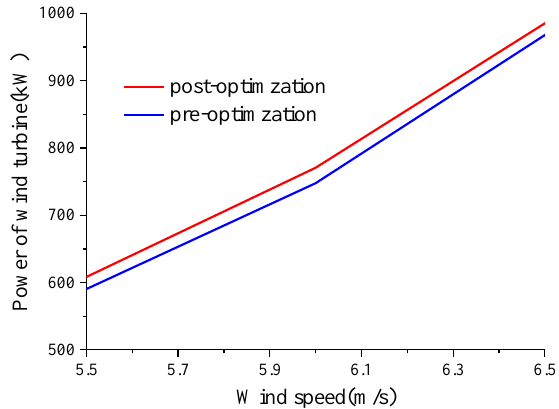
Figure 9. Wind turbine blade power at low wind speed before and after optimization.